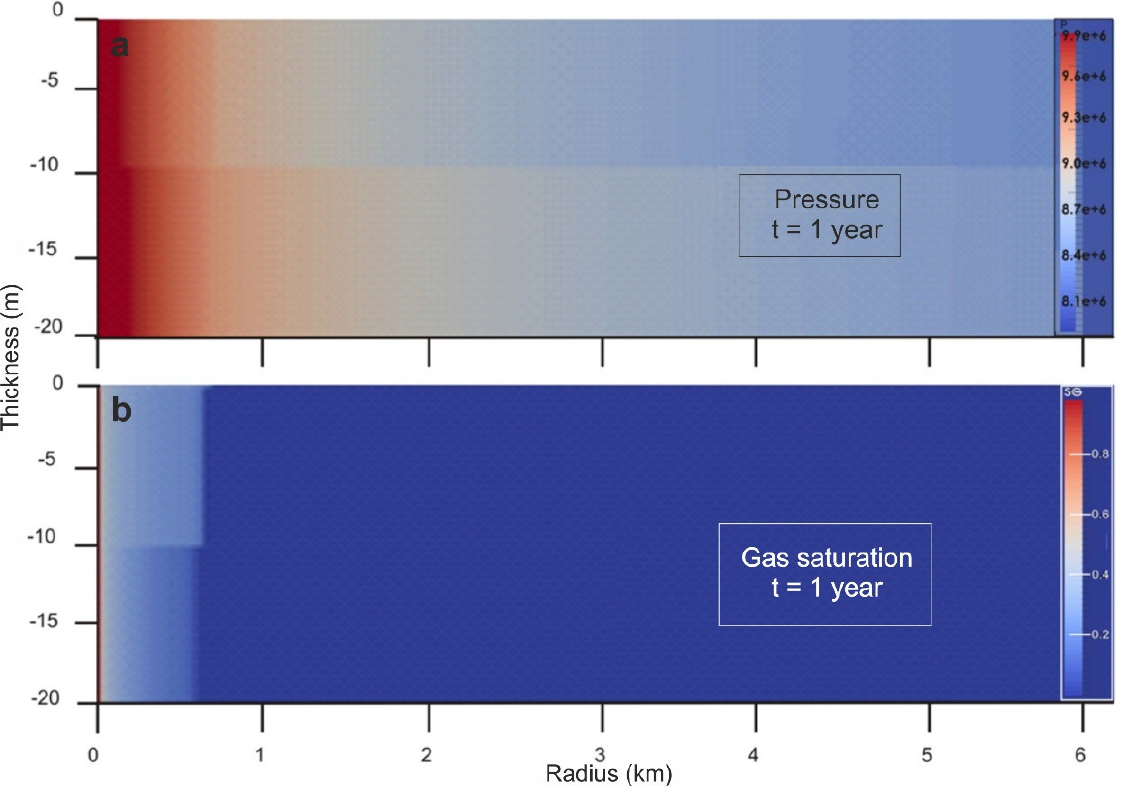
Figure 1. Evolution of the pressure (unit Pa) in the reservoir ( a ) and the gas saturation (forehead of plume of the injected CO 2 ) in the first year after injection (scale of the value of the CO 2 in the porous medium) ( b ). CO 2 injection started at point 0 on both the x–axis and y–axis.